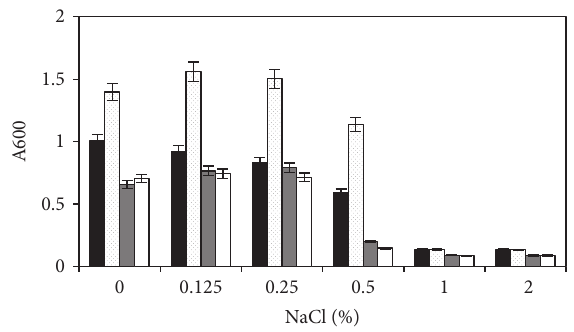
Figure 3: Growth of wild type C. perfringens ATCC 13124 and mutant 13124 GR with different concentrations of NaCl in the absence and presence of trehalose. Black bars (wild type without trehalose), gray bars (mutant without trehalose), dotted bars (wild type with trehalose), and white bars (mutant with trehalose). OD was measured after 24 hours’ anaerobic incubation at 37 ∘